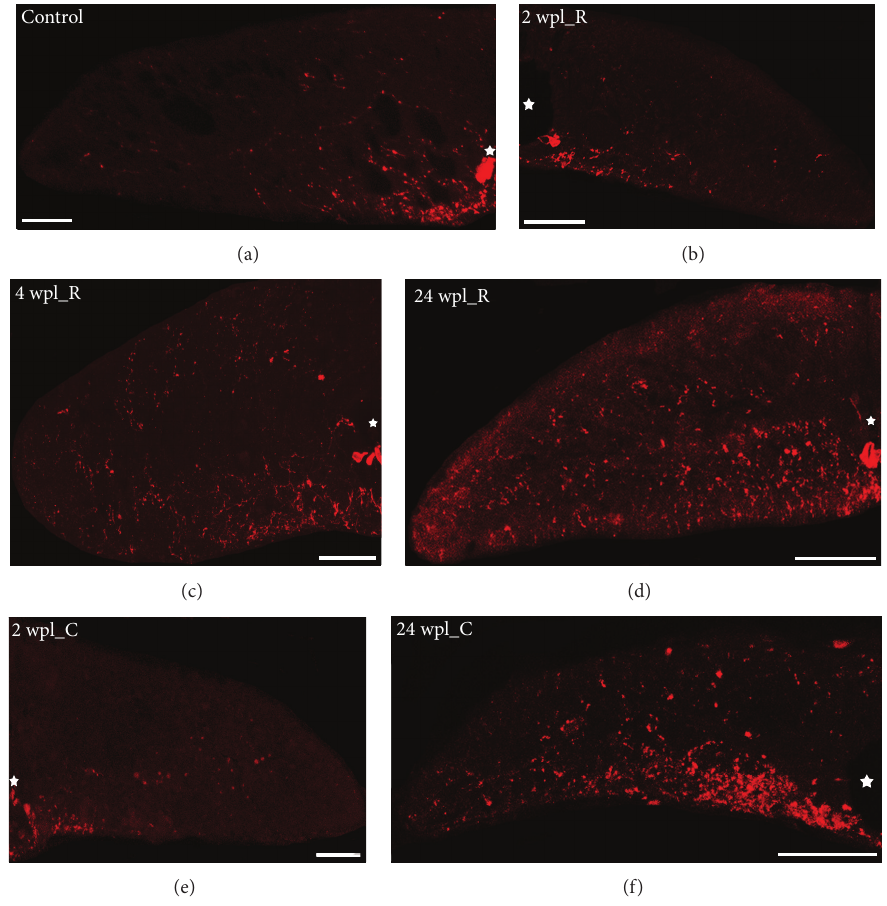
Figure 2: Confocal photomicrographs of transverse sections of the spinal cord showing details of the dopaminergic innervation of the spinal cord in control and lesioned animals. (a) Dopamine-ir fibers in a control unlesioned larva. (b) Dopamine-ir fibers in the rostral stump of a 2 wpl larva. (c) Dopamine-ir fibers in the rostral stump of a 4 wpl larva. (d) Dopamine-ir fibers in the rostral stump of a 24 wpl larva. (e) Dopamine-ir fibers in the caudal stump of a 2 wpl larva. (f) Dopamine-ir fibers in the caudal stump of a 24 wpl larva. Star indicates the central canal. In all microphotographs dorsal is at the top. Scale bars = 50 𝜇